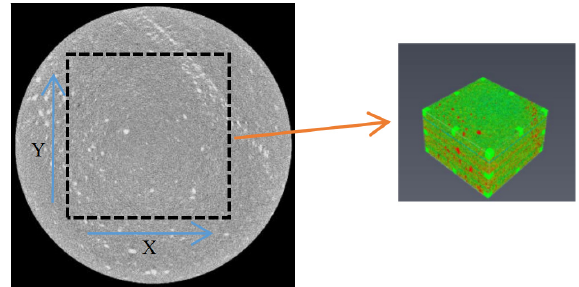
Figure 13. DVC computational area.